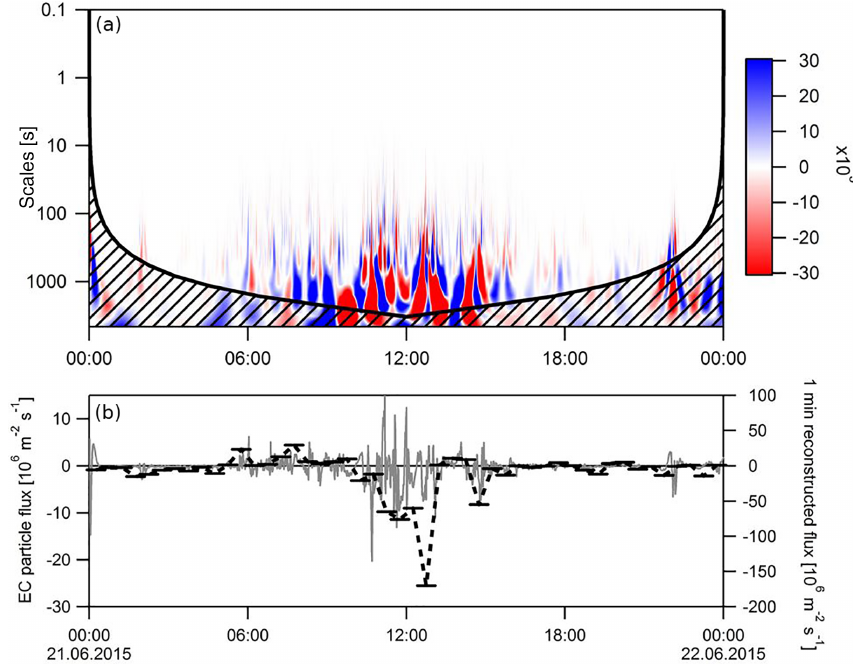
Figure 7. Cross wavelet spectrum of vertical wind and particle number from an EC station on 21 June 2015 (a) . Colours indicate positive and negative contributions of different timescales to the particle flux over the day. During sporadic new particle formation (NPF), deposition was observed (red), in contrast to emission during non-event sections (blue). The hatched regions at both ends show the cone of influence, where edge effects influence the wavelet analysis. (b) Particle fluxes calculated by standard eddy covariance procedures for 30min intervals (black dashed line), and reconstructed from wavelet analysis for 1min intervals (grey). The 30min EC particle fluxes show significant deposition affected by NPF at 12:30UTC.